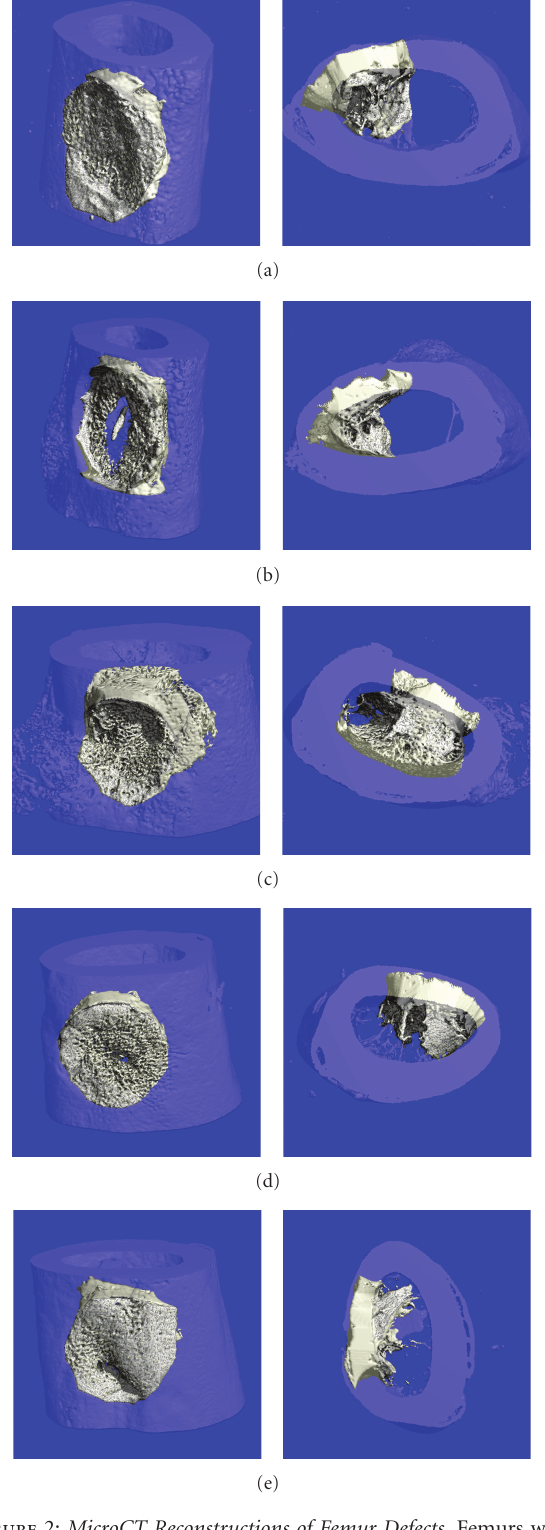
Figure 2: MicroCT Reconstructions of Femur Defects . Femurs were harvested 3 weeks after surgery and analyzed for bone formation by microCT. Shown are lateral (left column) and cross-sectional projections (right column) of (a) an empty defect and defects treated with (b) a blank, (c) high-dose alendronate, (d) high-dose lovastatin, and (e) high-dose omeprazole.